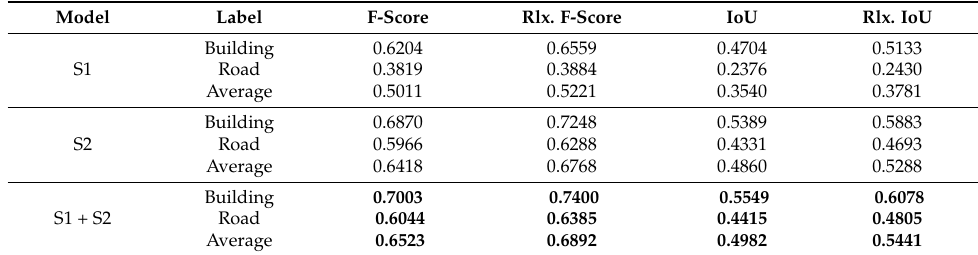
Table 2. Comparison between using S1 and S2 data individually and fusing the information provided by both